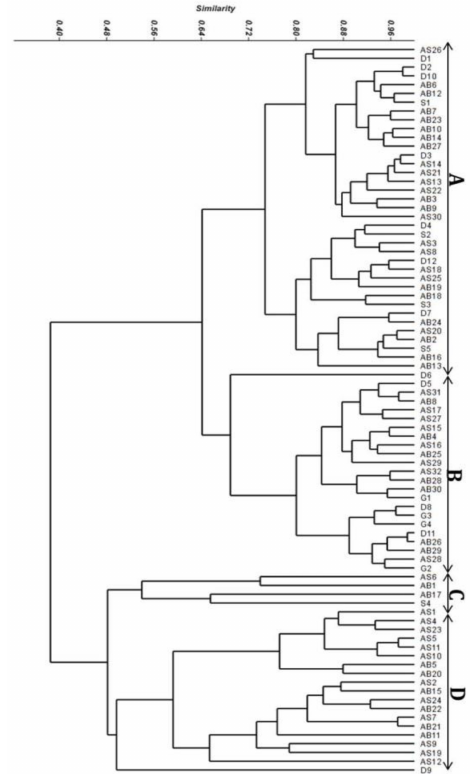
Figure 3. Dendrogram cluster analysis of the studied 83 stands of Assiut Governorate with the groups